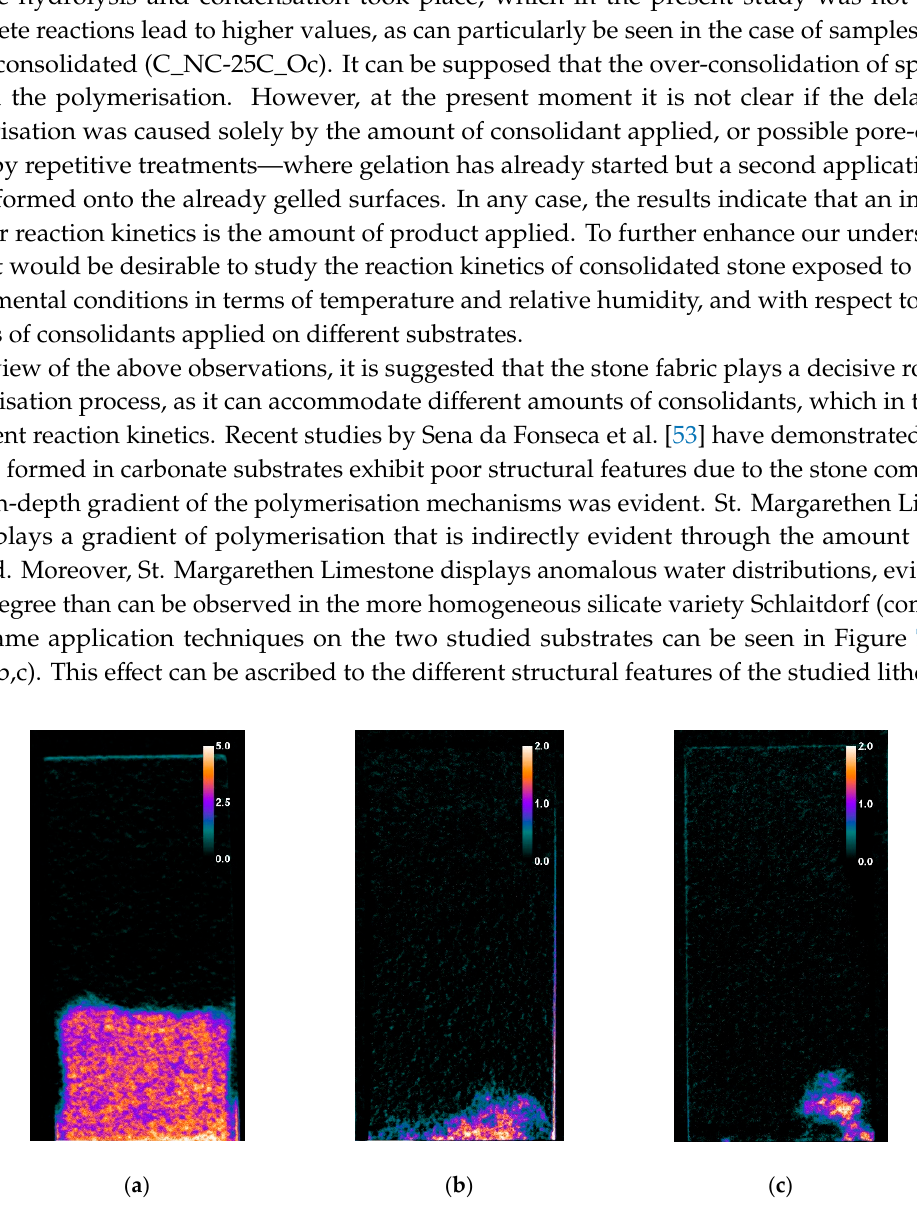
Figure 8. Radiographs of Schlaitdorf Sandstone recorded at 30 min of water absorption by capillarity for specimens treated with NC-25C by ( a ) capillary absorption, ( b ) brushing and ( c ) poultice. The calibration bar displays the water amount in wt. %.